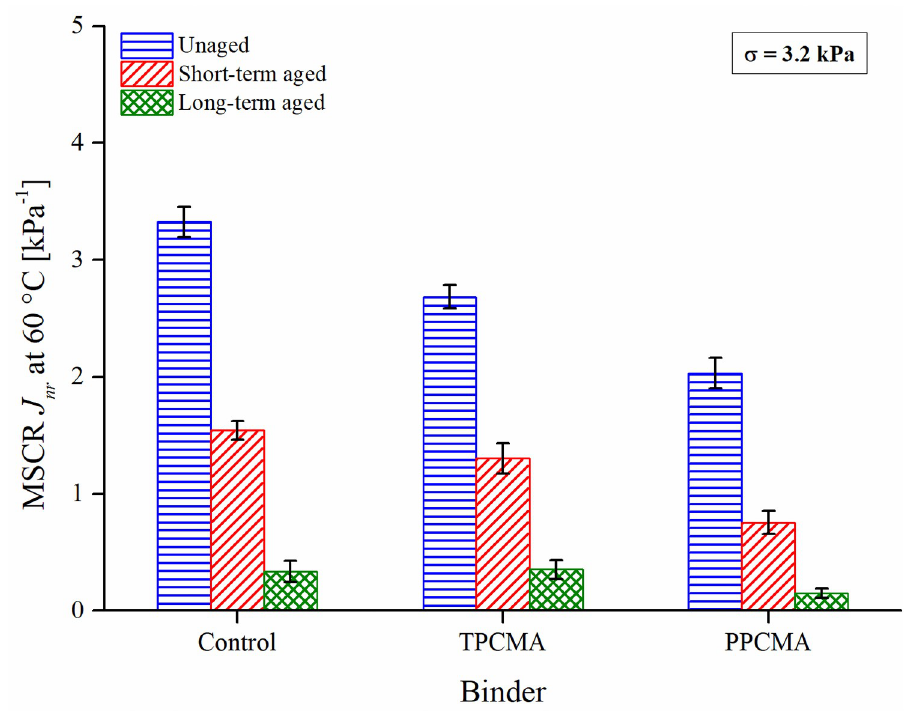
Fig 9. MSCR J nr result at